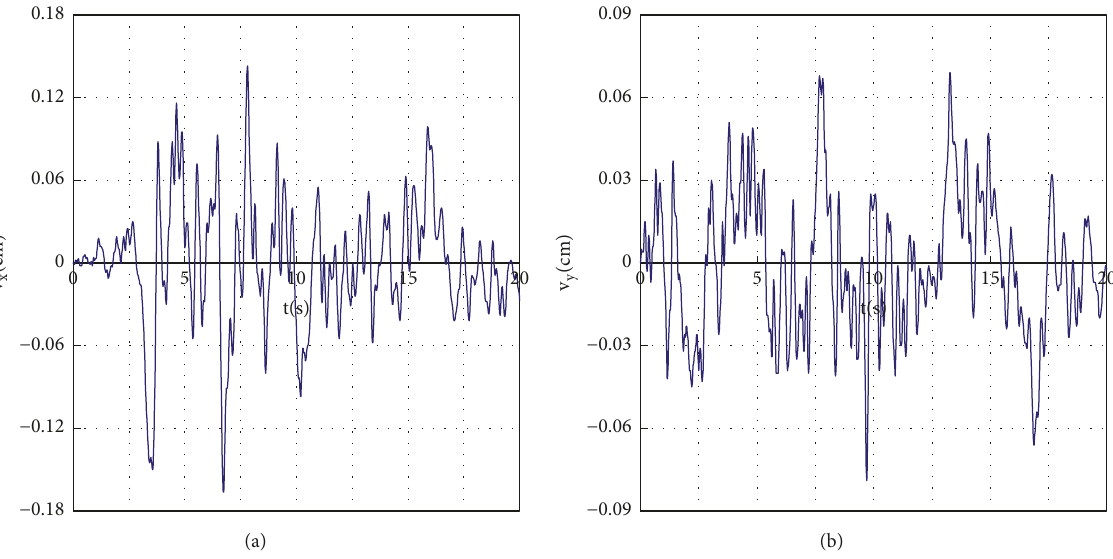
Figure 11: Velocity time history of Taft earthquake: (a) horizontal and (b) vertical.